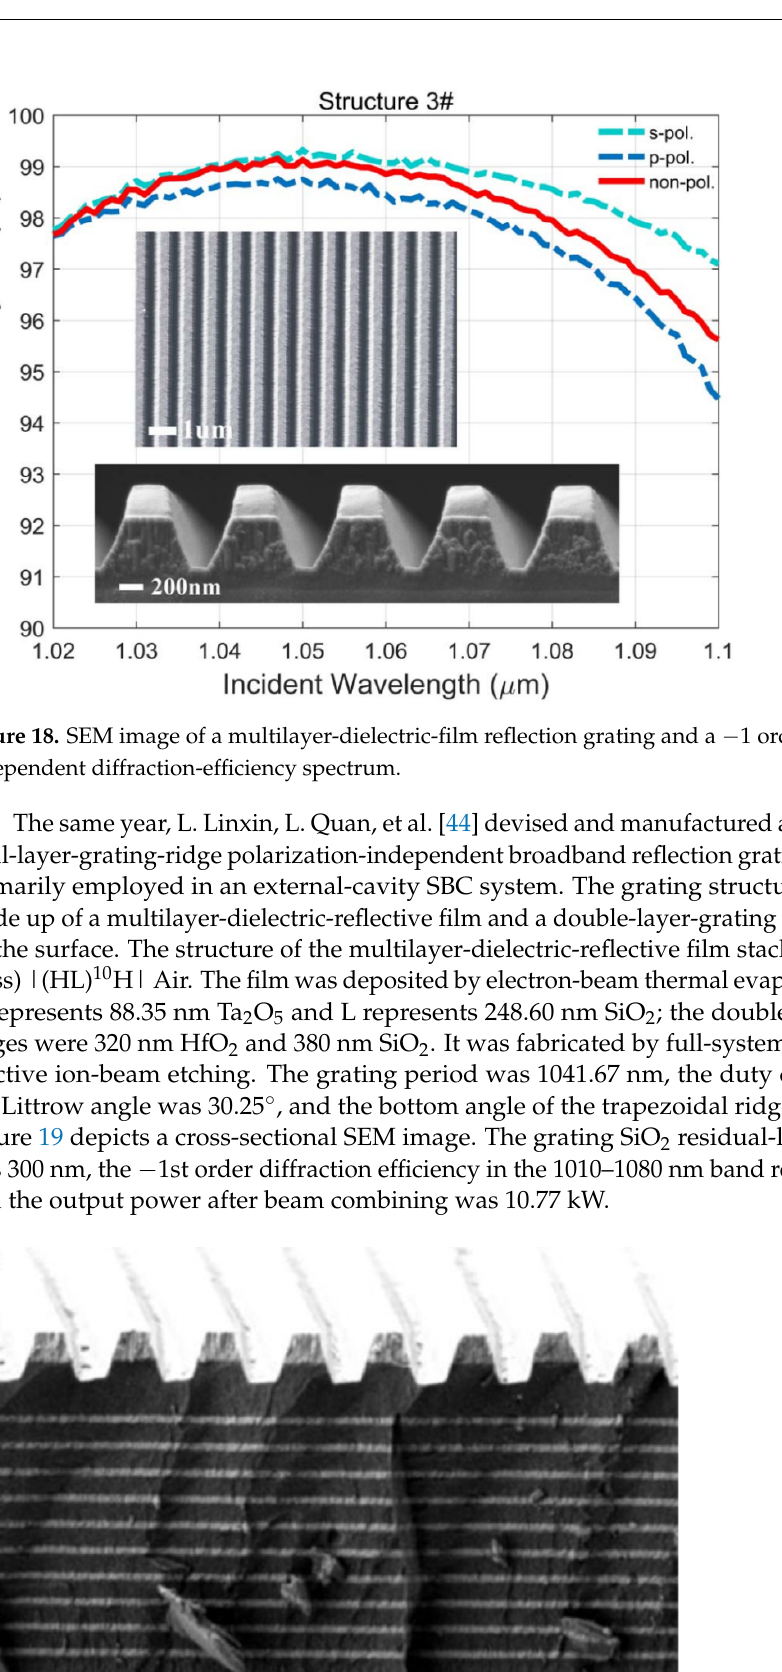
Figure 17. Different grating designs in the 1020–1100 nm band: ( a ) − 1st di ff raction e ffi ciency =